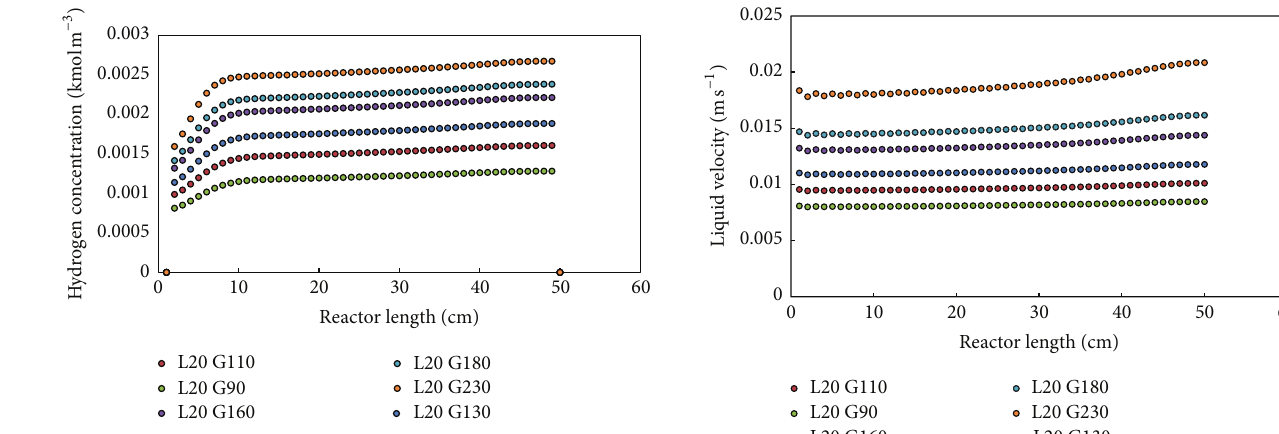
Figure 6: Calculated hydrogen concentration in the washcoat layer along the reactor length for a liquid flow rate of 20 mLmin −1 and various gas flow rates.